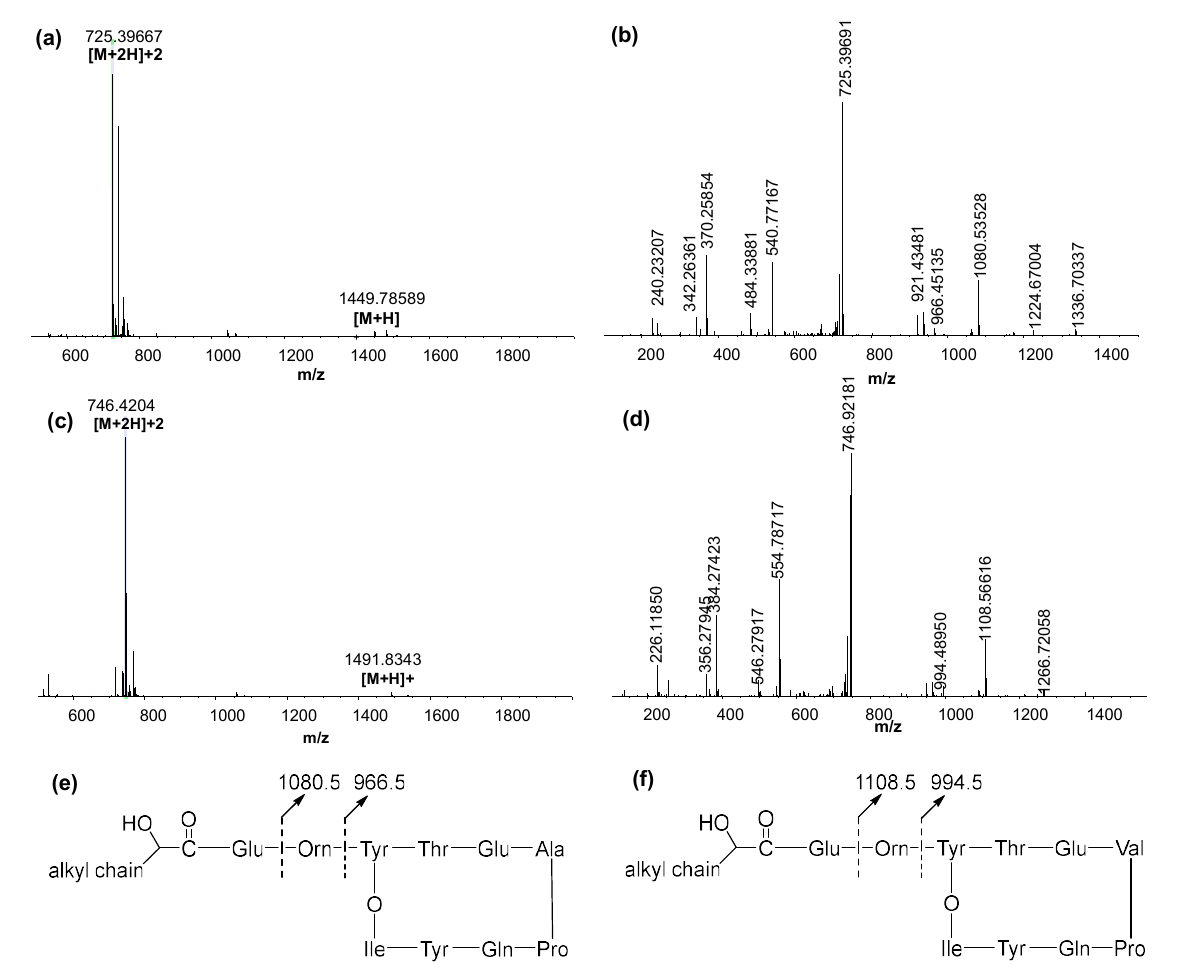
Figure 4. ( a , b ) The MS and MS/MS spectra of a fengycin A derivative from [M + H] + 1449.7859. ( c , d ) The MS and MS/MS spectra of a fengycin B derivative from [M + H] + 1419.8343. ( e , f ) Illustration of the identical product ions derived from fengycin A and fengycin B, respectively. Table 2. Precursor ions, identical product ions, fatty acid chain length, and fengycin